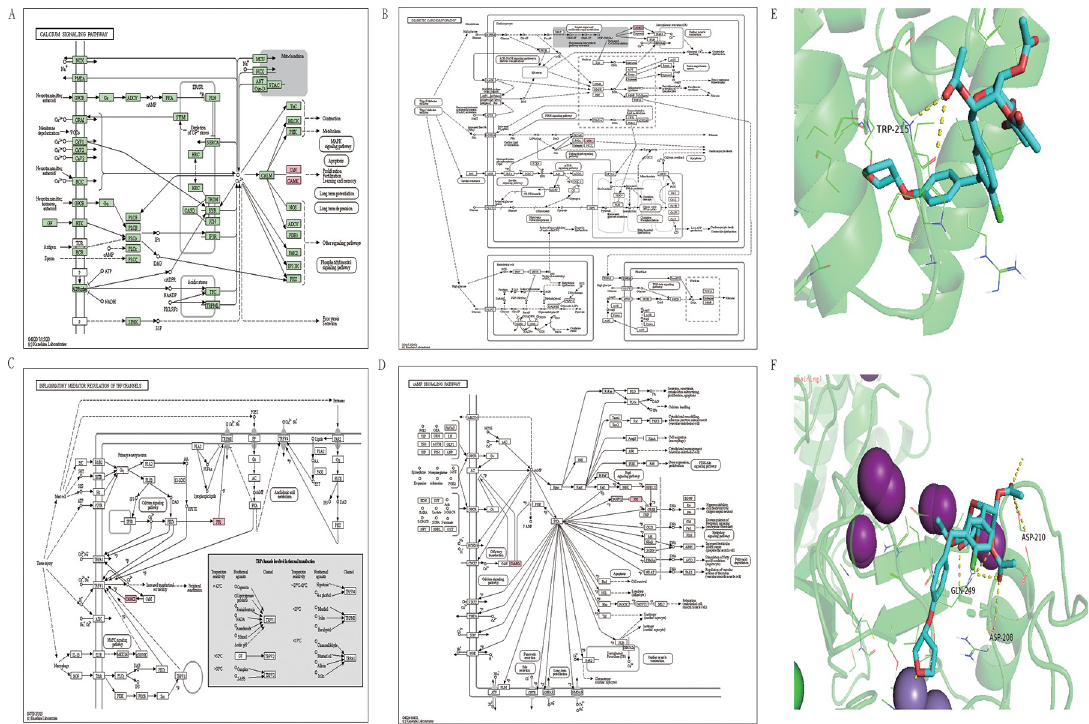
Fig 4. A. KEGG pathway diagram of hsa04020, Calcium signalling pathway. B. KEGG pathway diagram of hsa04024.cAMP signalling pathway. C. KEGG pathway diagram of hsa04750. Inflammatory mediator regulation of TRP channels. D. KEGG pathway diagram of hsa05415.Diabetic cardiomyopathy. E. Molecular docking diagram of CaMK2G and Empagliflozin. Empagliflozin binds to the TRP-215 residue of CaMK2G. F. Molecular docking diagram of PPP1CA and Empagliflozin. Empagliflozin binds to residues GLN-249 ASP-210 ASP-208 of PPP1CA. The purple spheres in the figure are iodide ions, and the green spheres are chloride ions.